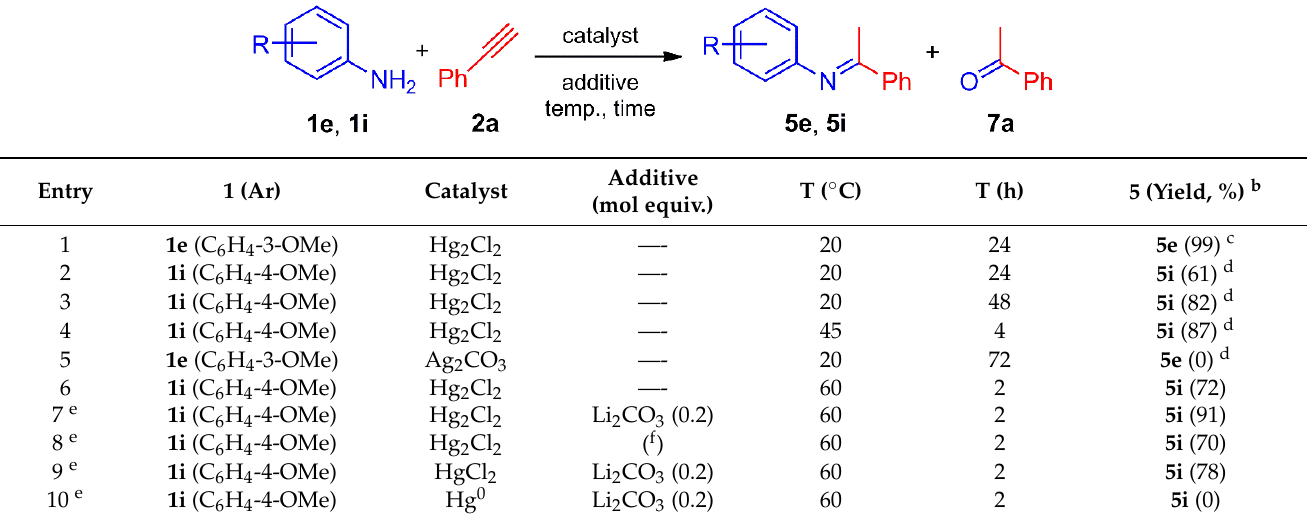
Table 1. Optimization of the preparation of N -arylimines 5e and 5i a .